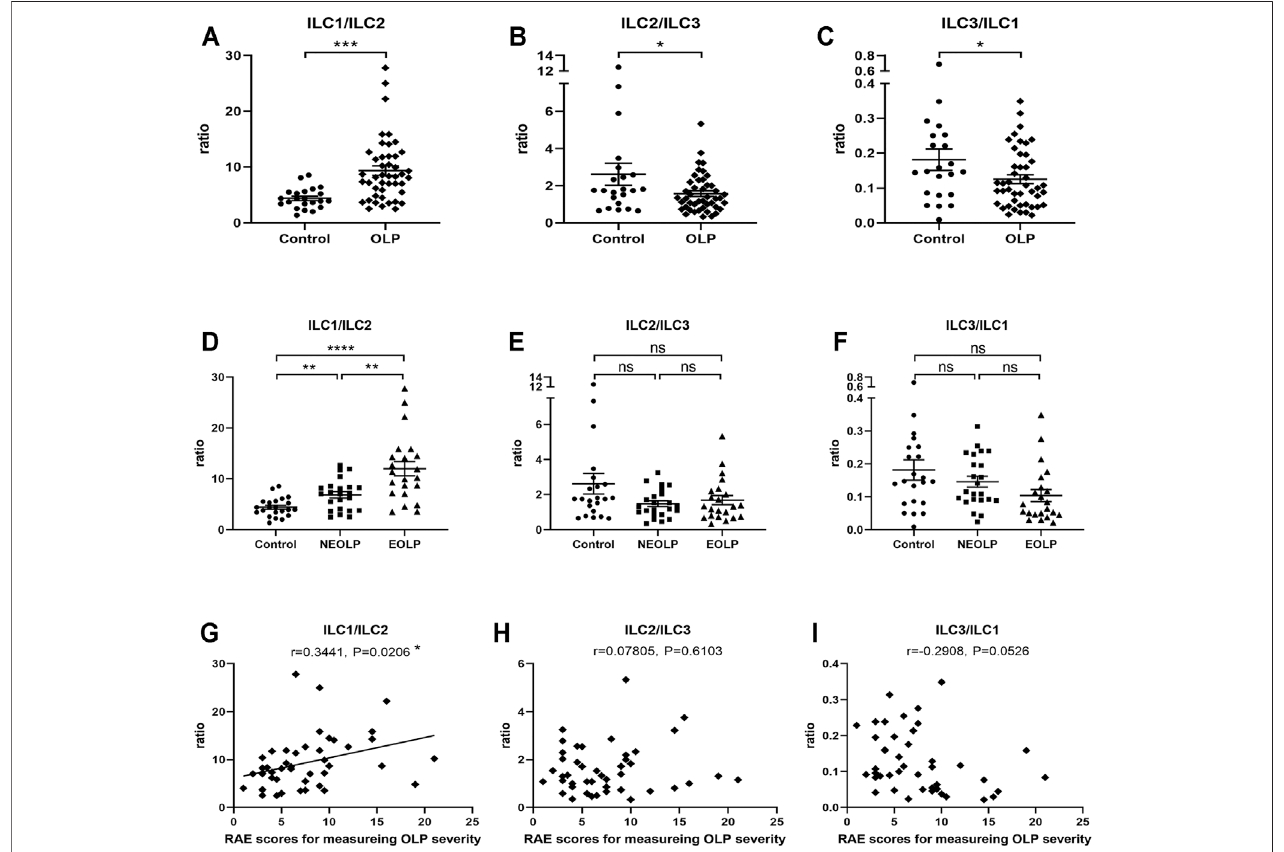
FIGURE3| AlteredILC1/ILC2balanceinOLP. (A – F) TheratiosofILC1/ILC2,ILC2/ILC3,andILC3/ILC1. (G – I) CorrelationofILC1/ILC3,ILC2/ILC3,andILC3/ILC1 ratios with corresponding disease severity in OLP. OLP, oral lichen planus.